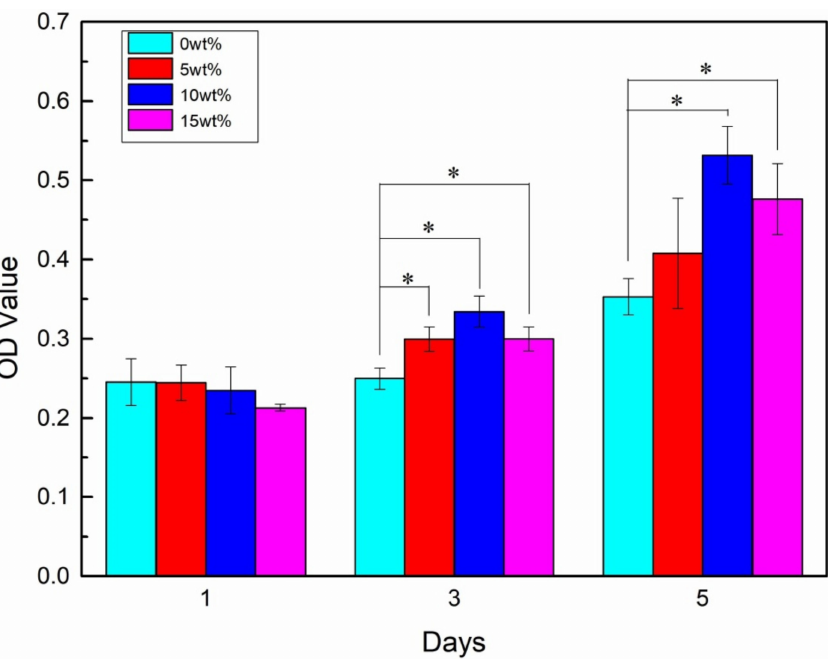
Figure 5. Optical density (OD) assay of MG63 cell on coatings with DE (0wt%, 5wt%, 10wt% and